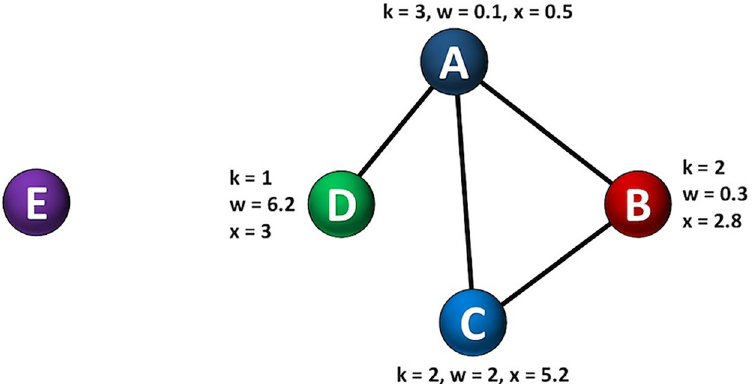
Fig 8. Illustration of a toy network. Each existing node in the network (nodes A, B, C, D) has properties such as degree k (how many transactions were made), wealth w (amount of bitcoins in wallet), and fitness x (the potential of node i to create new connections, where different types of users in the system have different intrinsic fitness. A new node E might chose to connect to any existing node depending on its preference—based on degree, wealth or fitness.